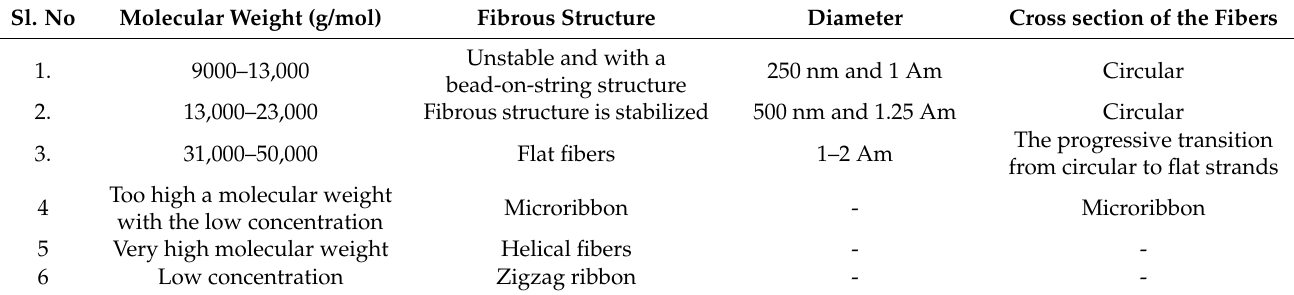
Table 4. SEM microstructure of the different fiber structures